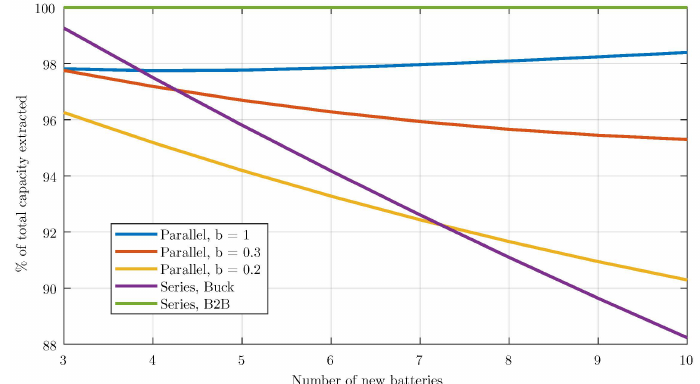
Figure 5. Percentage of energy extracted from a bank with 20 batteries depending on the system architecture, when the new batteries change ( x